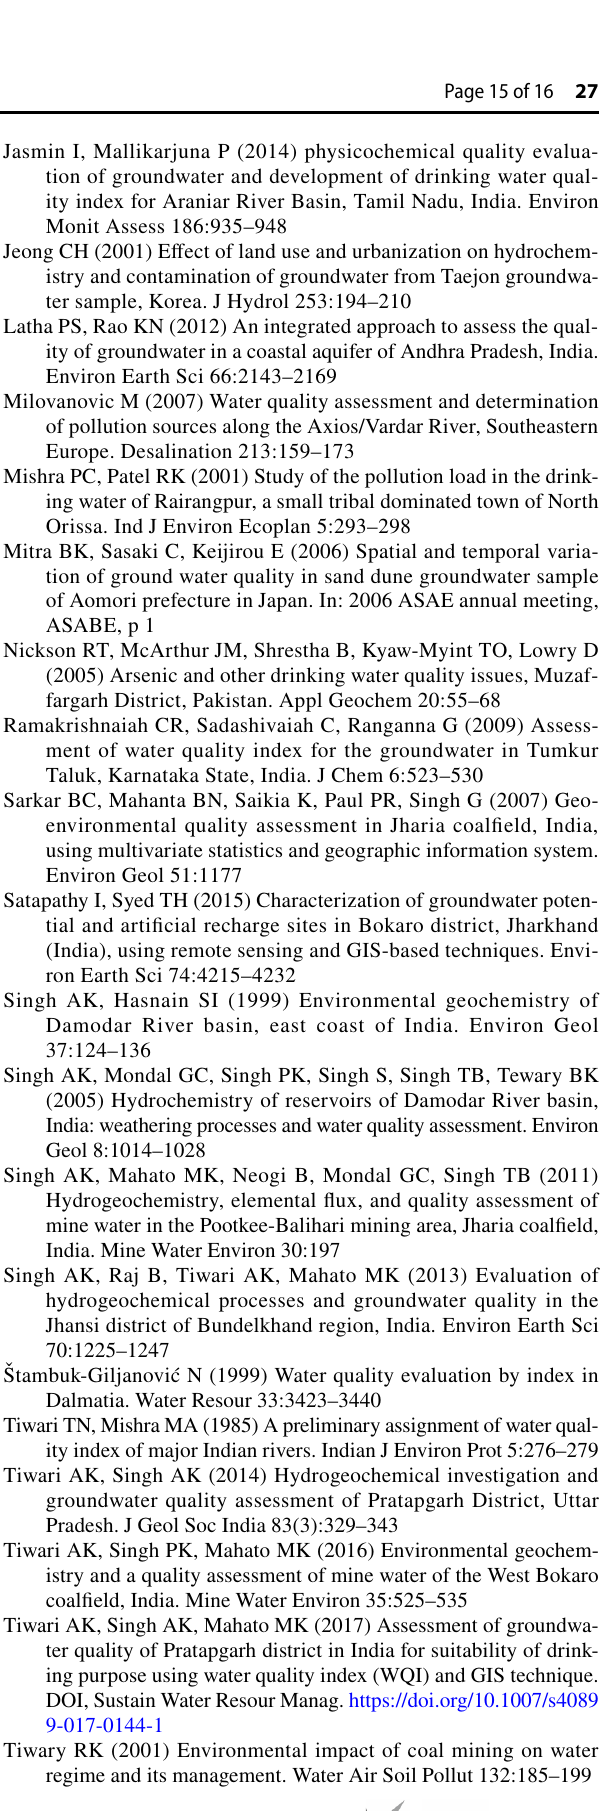
% of samples the pre-monsoon in the